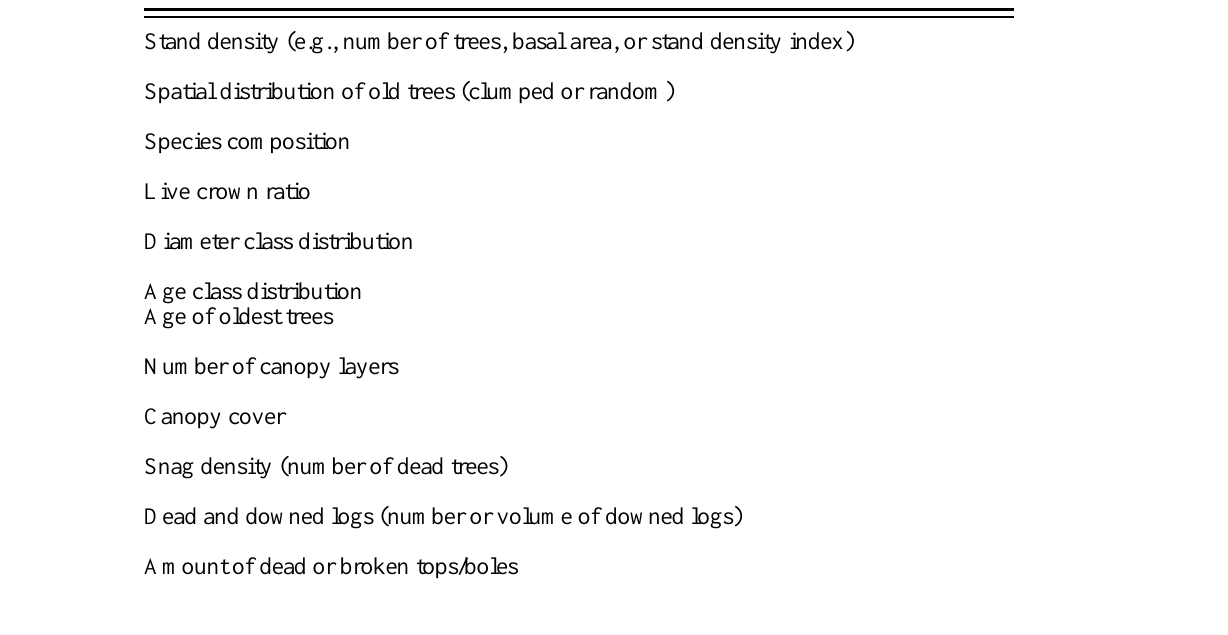
Table 1. Structural indicators of old